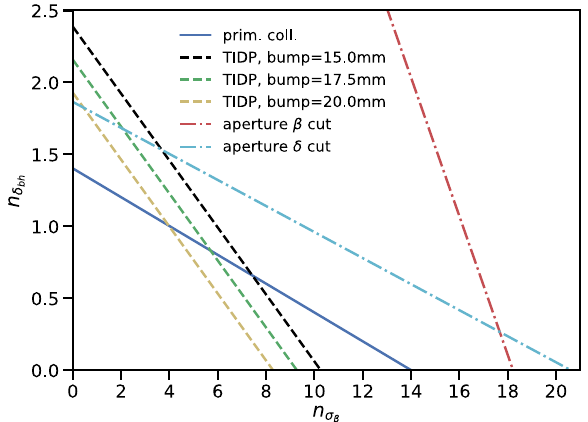
FIG. 6. Cut in phase space provided by the two stages of the baseline proposal of the SPS off-momentum collimation system. The expected post-LS2 aperture has been